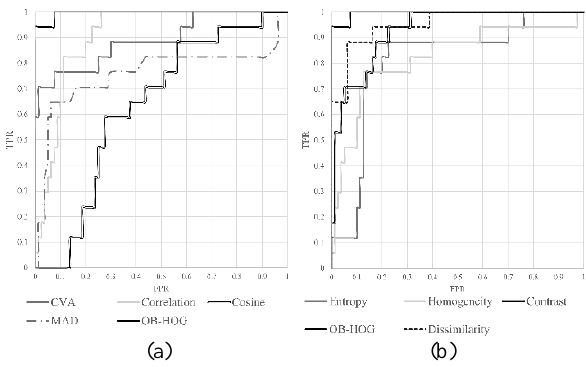
Figure 5: ROC curves of the OB-HOG and the (a) spectral (b) textural change detection methods.